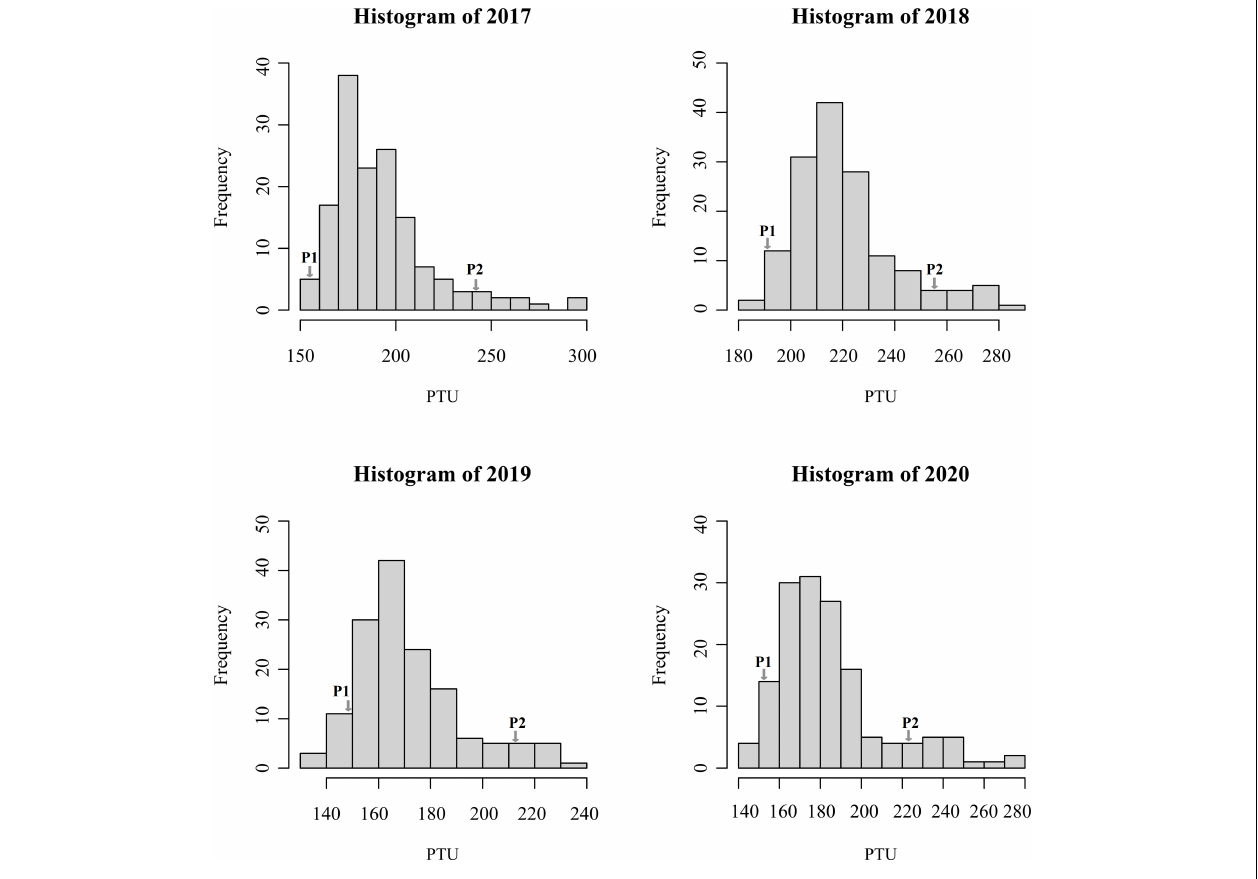
Frontiers in Plant Science |